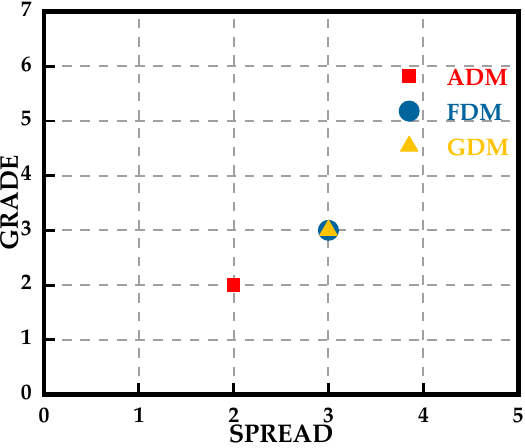
Figure 20. GRADE-SPREAD chart of the data of Figure 17.